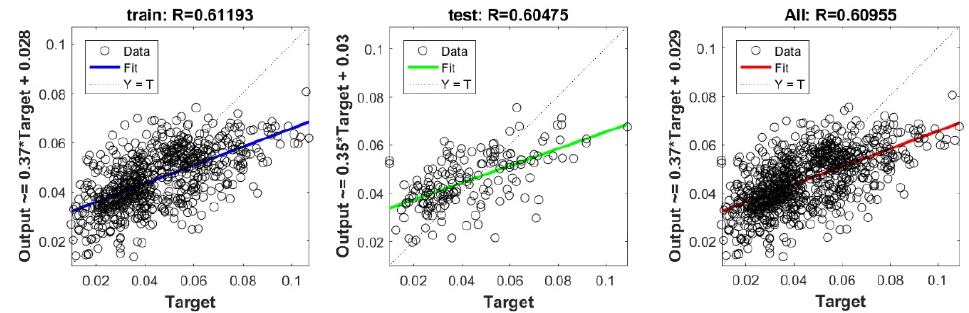
Figure A5. Scatter plots between target and output value by the FS-KRidge model.